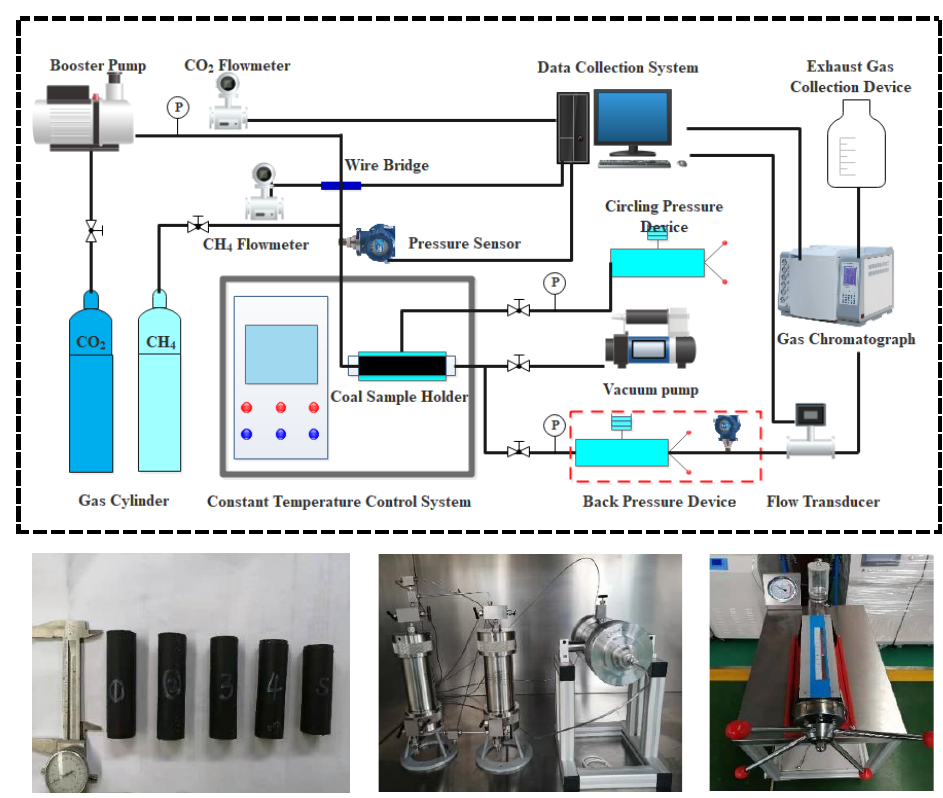
Figure 1. The experimental system diagram of CO 2 displacement coal seam CH 4